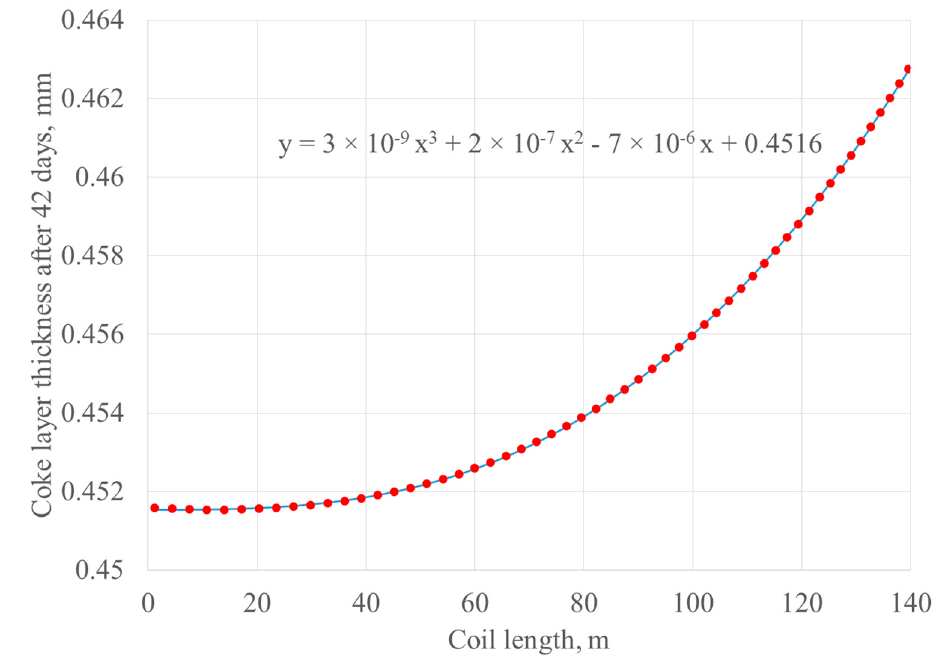
Figure 2. Coke layer thickness depending on the coil length at the end of the pyrolysis furnace coil.